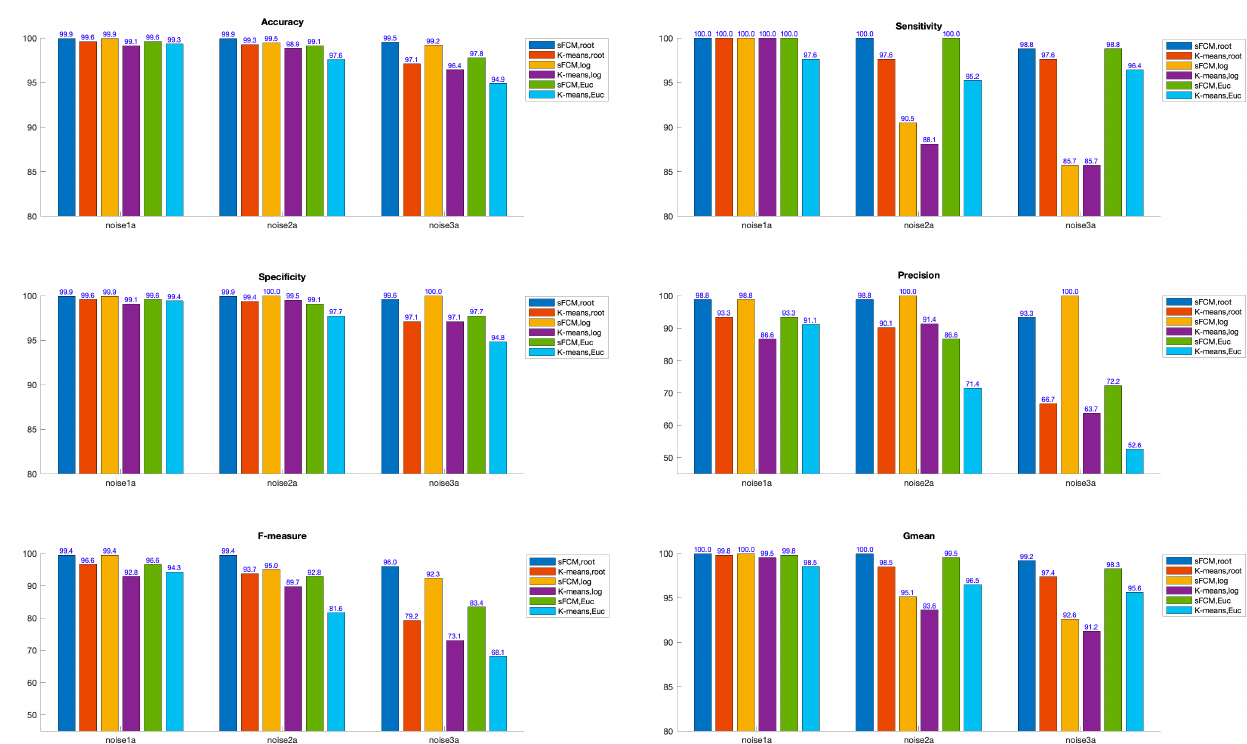
Figure 3. Bar charts of the performance measures for Simulation Study 1. Overall, sFCM yields higher values of performance measures as compared to K-means, whilst root Euclidean yields the highest performance measures. To enable better visualisation of the results, a scale of 45–100 for precision and F-measure and 80–100 for the rest of the measures is